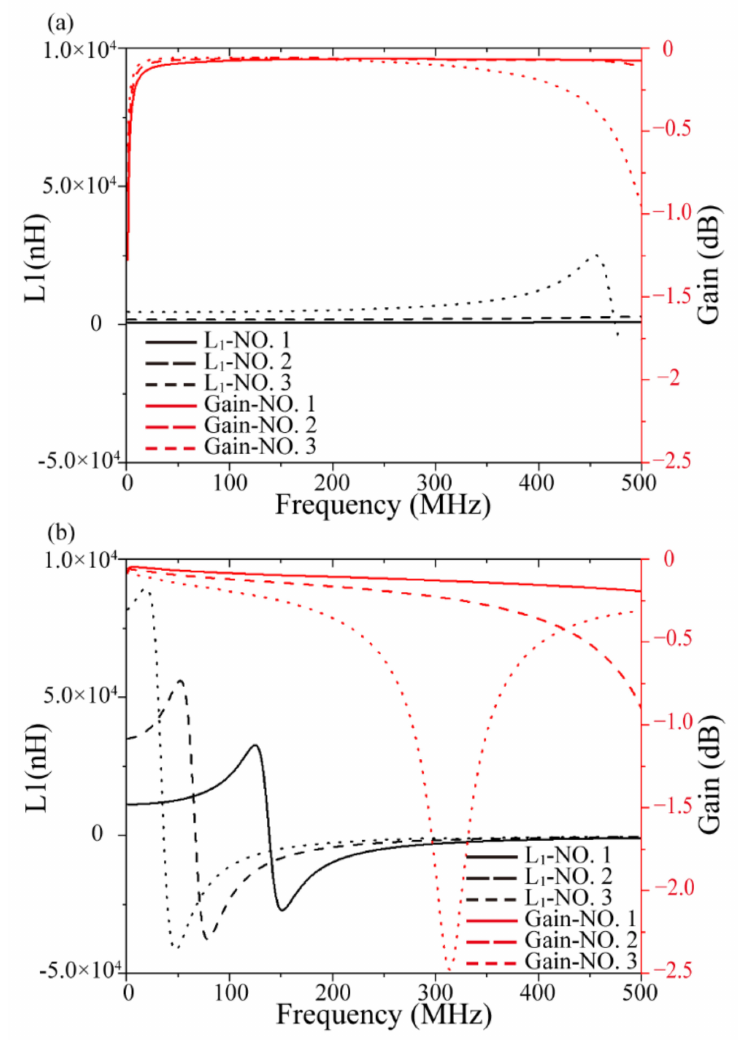
Figure 6. Inductance and maximum available gain of transformer with ferrite core. ( a ) Solenoidal and ( b )